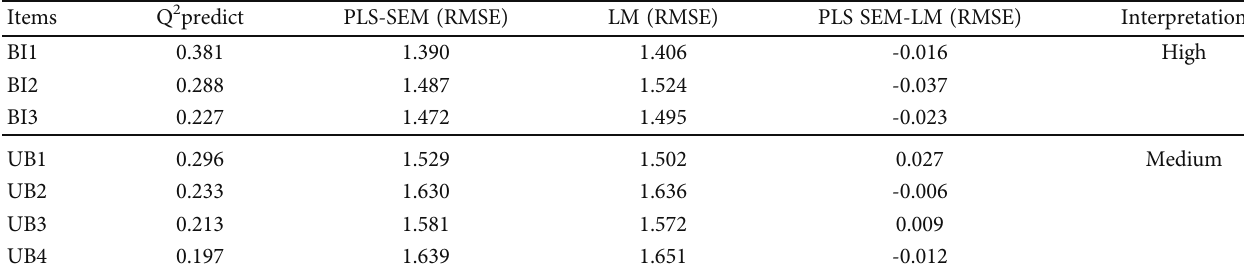
Figure 3: Moderating role of perceived service quality on behavioral intention and use behavior. Table 5: